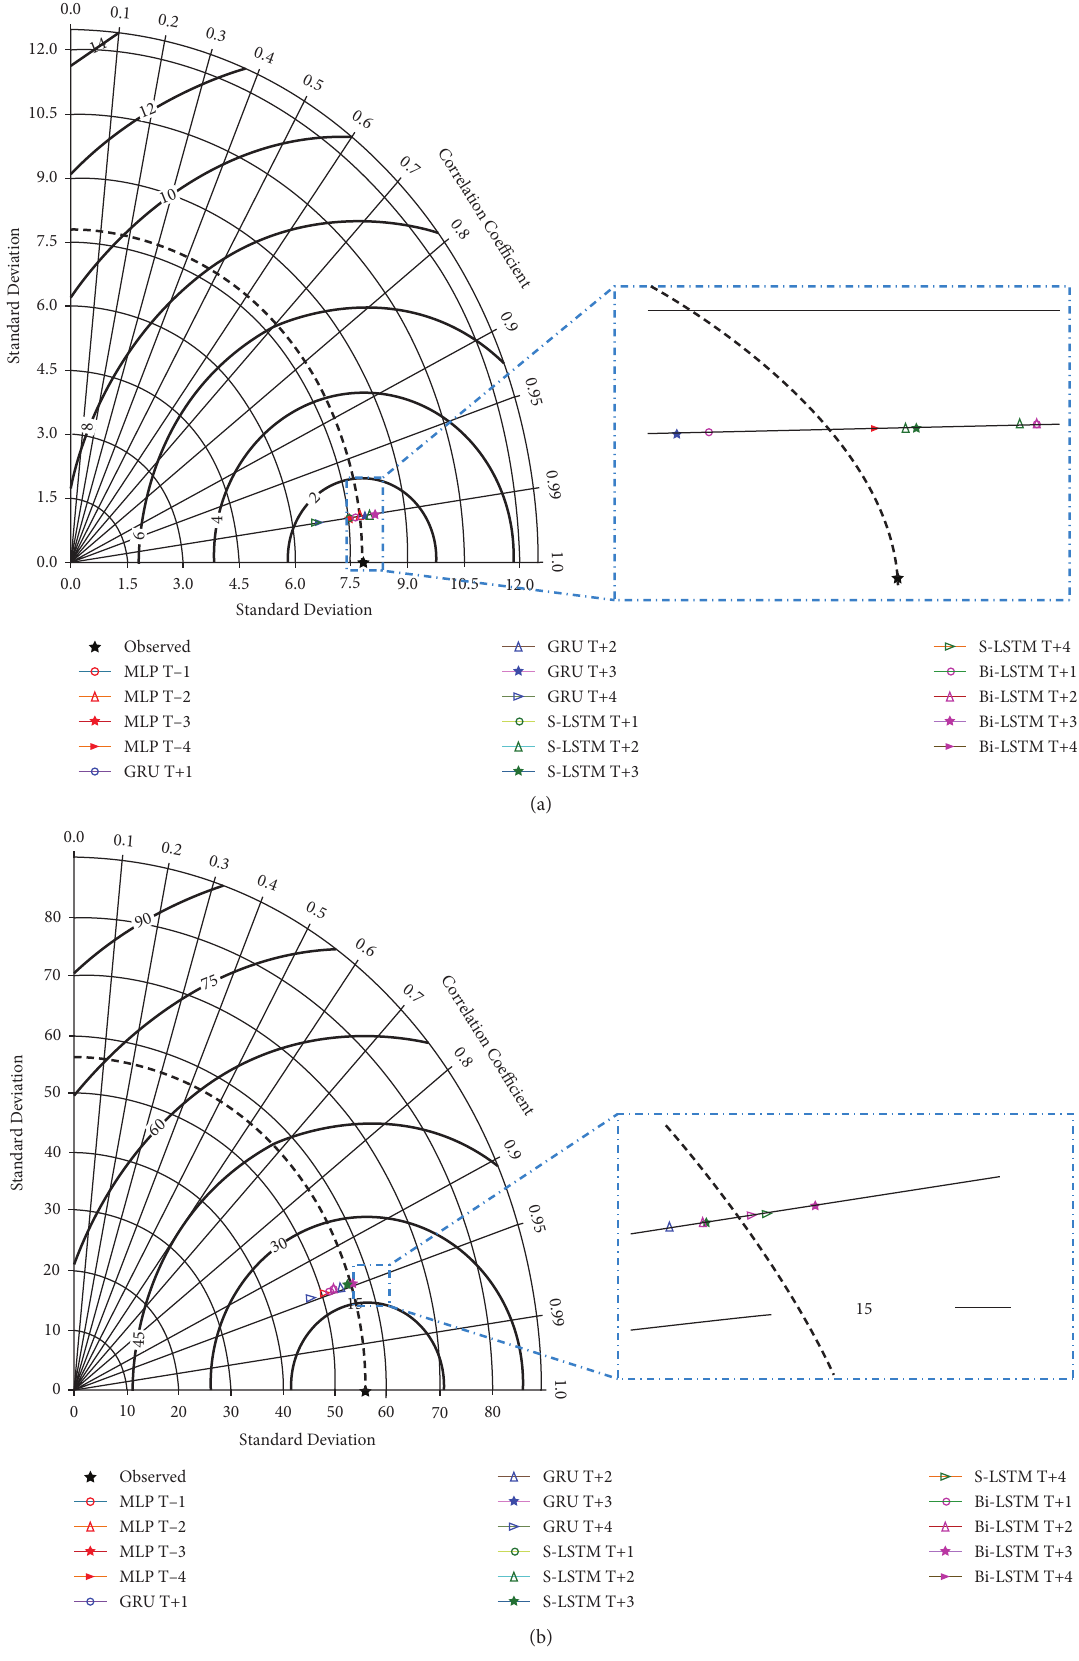
Figure 12: Taylor diagram displays the standard deviations, root mean square error, and correlation coefficient between observed and predicted streamflow for the proposed four models and lagged time variables (Q m 3 /s). (a) Borkena, (b)